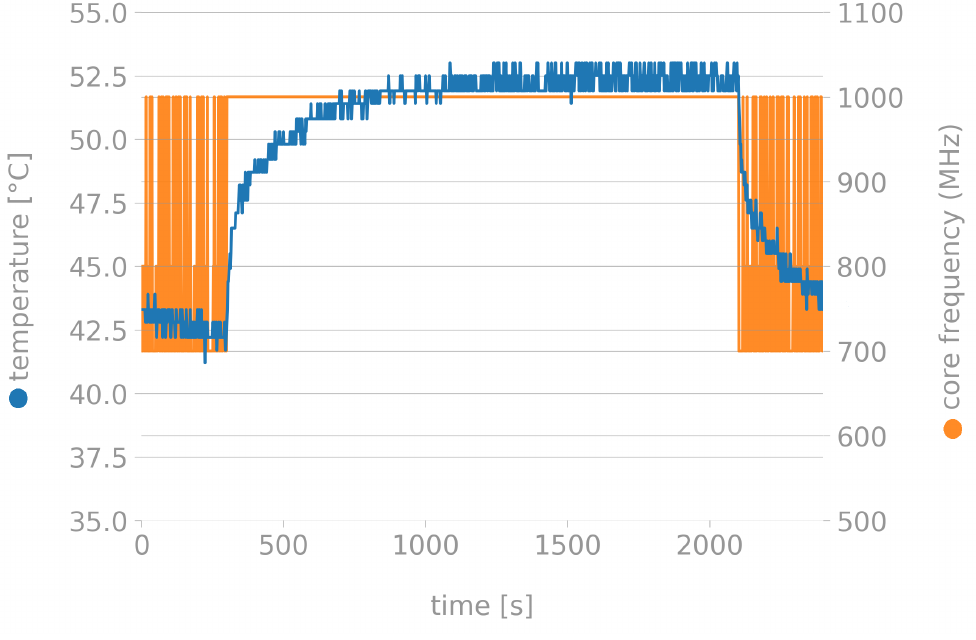
Figure 4. Camera module stress test